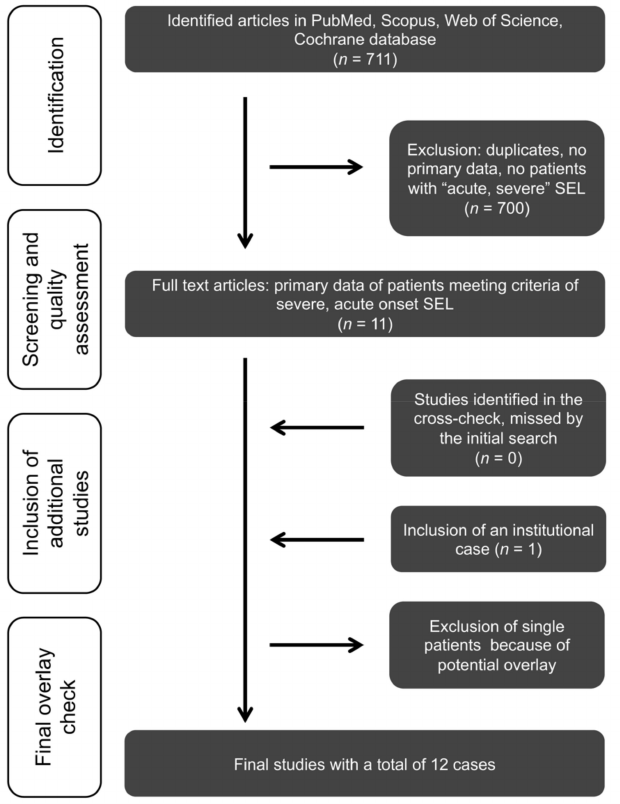
Figure 1. Flow chart of the systematic literature review. The inclusion and exclusion process of the initial 711 studies identified by PubMed, Scopus, Web of Science, and Cochrane database searches (Figure S1) are shown stepwise in the flow diagram. Abbreviation: SEL—spinal epidural